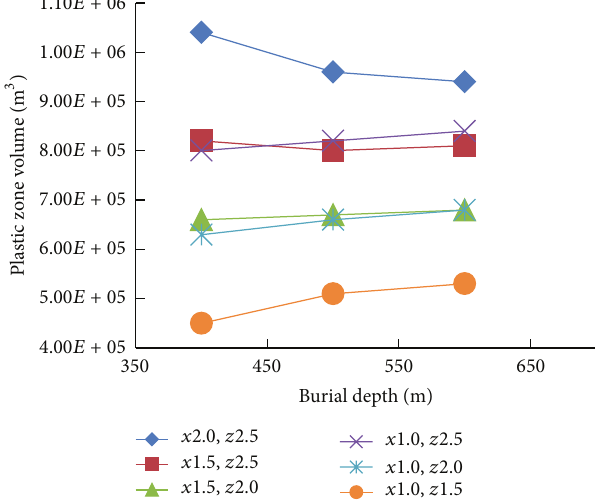
Figure 10: Total plastic zone volume versus burial depth under varying lateral pressure coefficient.